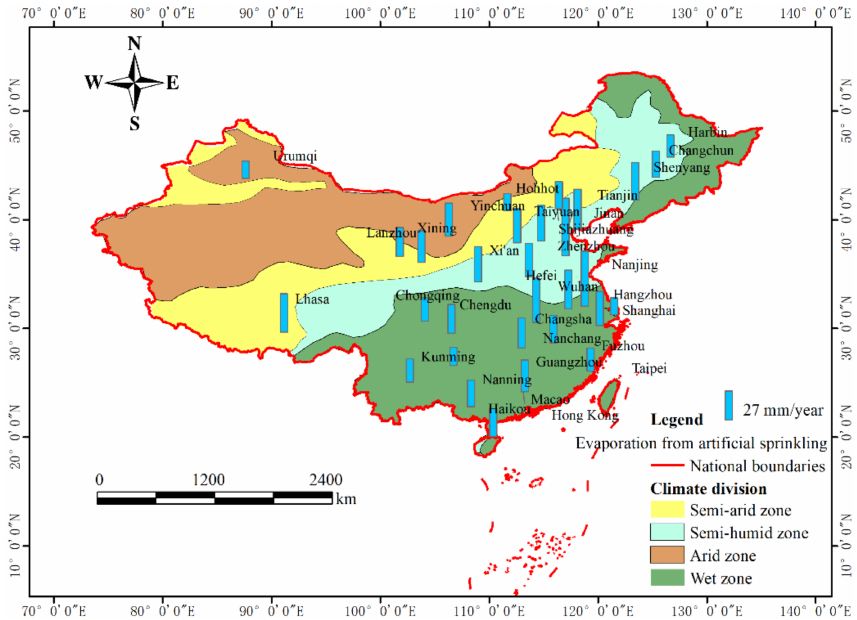
Figure 5. Evaporation intensity of impervious surfaces from artificial sprinkling on built-up areas in provincial capital cities in China in 2015.